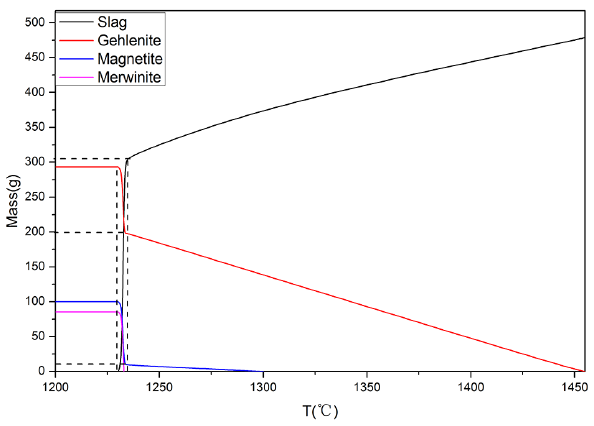
Figure 8. Masses of gehlenite, merwinite, magnetite, and slag at each thermodynamic equilibrium state